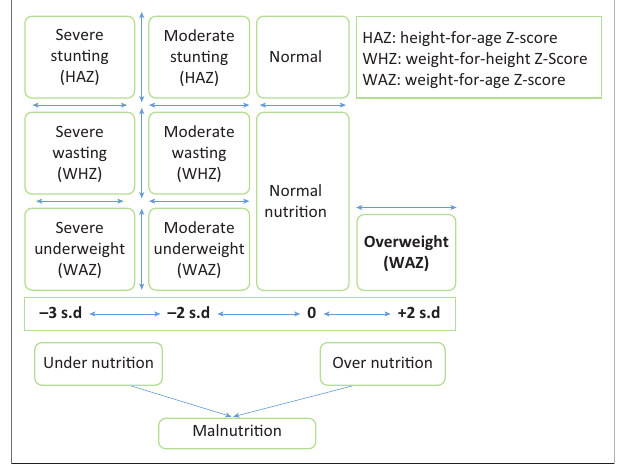
FIGURE 3: Pattern of malnutrition in children under the age of 5